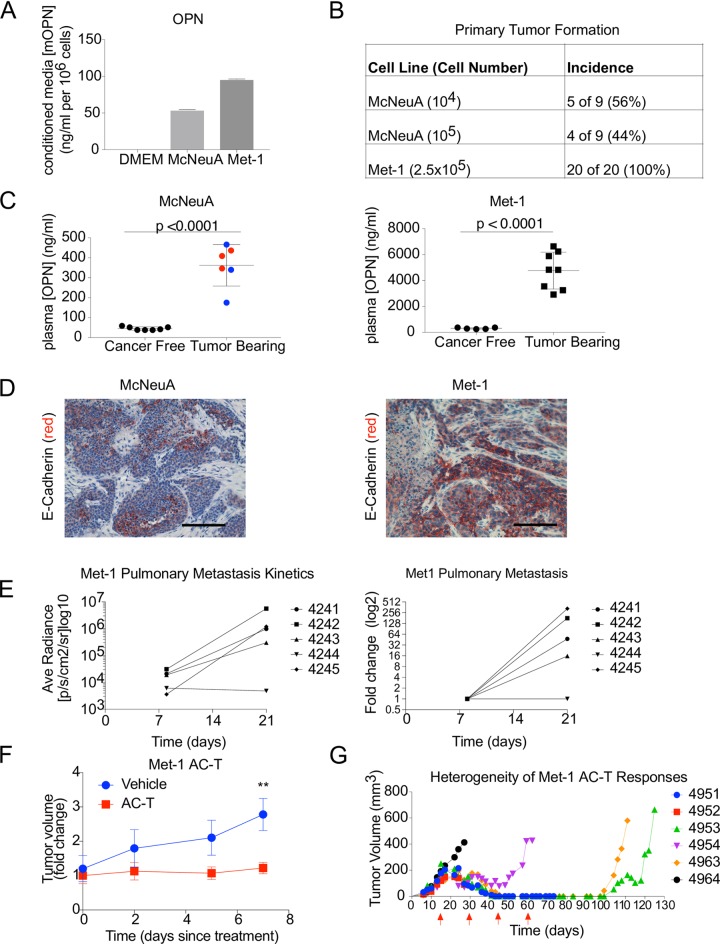
Phenotypic and functional heterogeneity of McNeuA and Met-1 breast cancer cells.(A) Concentration of murine OPN (mOPN; ng/ml per 106 cells) in 24-hr conditioned medium of McNeuA and Met-1 murine mammary carcinoma cells represented as mean ± SD. There was no detectable mOPN in the control cell-free medium (DMEM) (2 technical replicates per group). (B) Incidence of tumor formation following injection of indicated numbers of McNeuA or Met-1 cells into cohorts of FVB mice. (C) Plasma mOPN concentration (ng/ml) in indicated cohorts of mice at experimental end points of 84 days (McNeuA) and 30 days (Met-1). For McNeuA tumor-bearing mice, blue data points represent 10,000 cells injected, red data points represent 100,000 cells injected; n = 6–7 for McNeuA cohorts; n = 5–8 for Met-1 cohorts. Error bars represent SD; statistical significance evaluated using unpaired, two-tailed Student’s t-test. (D) Representative images of immunohistochemical staining for murine E-cadherin (red) on recovered McNeuA and Met-1 tumors. Cell nuclei were counterstained with hematoxylin (blue). Scale bars = 100 μm. (B-D) representative of 3 independent experiments per cell line. (E) Average radiance (log10) per mouse (n = 5) as measured by bioluminescence imaging over 21-day time course following intravenous injection of 106 Met-1 tumor cells into FVB mice (left graph). Fold-change (log2) in pulmonary metastatic burden per mouse (right graph). Representative of 2 independent experiments. (F) Response of orthotopic Met-1 GFP/Luc tumors to single dose combination doxorubicin (5 mg/kg), paclitaxel (10 mg/kg) and cyclophosphamide (120 mg/kg) (AC-T), n = 5–8 tumors/group. Ordinate represents time (days) following treatment. Error bars represent SEM; two-way ANOVA Sidak’s multiple comparisons test; **p<0.01. Representative of 3 independent experiments. (G) Growth kinetics of individual orthotopic Met-1 Luc/GFP tumors in mice injected with 2.5 x 105 tumor cells at the experiment initiation, subsequently receiving 4 biweekly AC-T doses (red arrows). Numbers and colors represent individual mice.